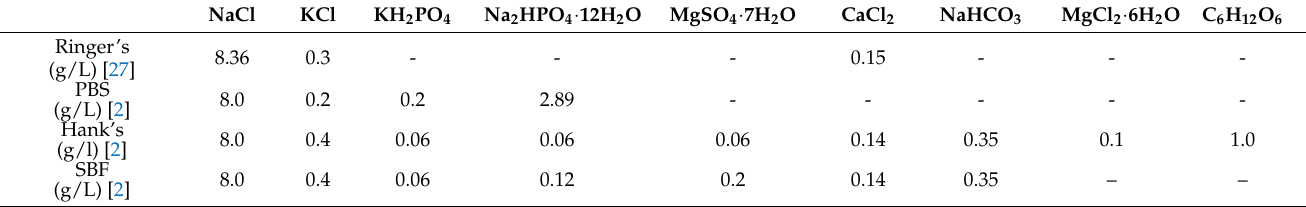
Table 2. Chemical compositions of four standard electrolyte solutions: Ringer’s, PBS, Hank’s, and SBF.